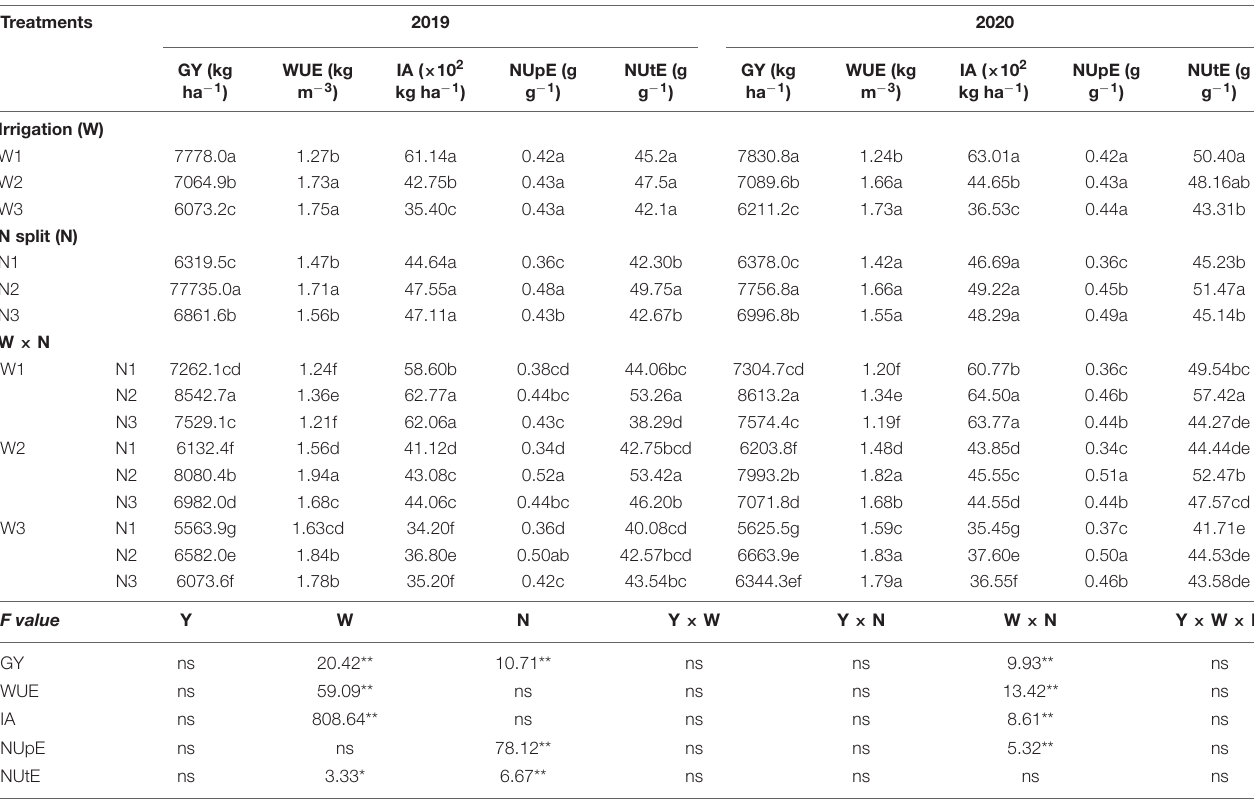
TABLE 7 | Effect of the irrigation methods and N split applications on grain yield (GY) water use efficiency (WUE), IA (irrigation amount), N uptake efficiency (NUpE), and N utilization efficiency (NUtE). Treatments